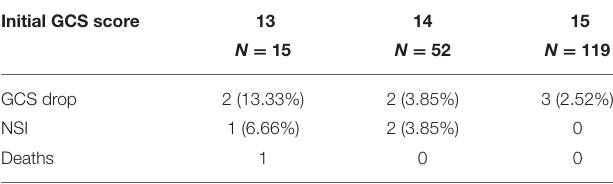
TABLE 2 | Results of analysis in each GCS group.